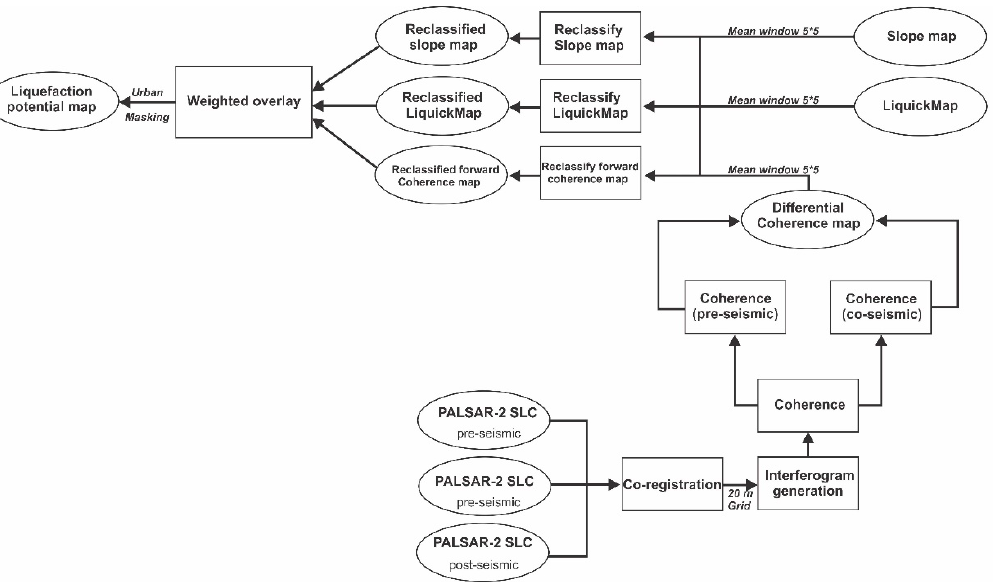
Figure 3. Flowchart of the weighted overlay (WO) analysis using synthetic aperture radar (SAR) coherence, LiquickMap and slope map.